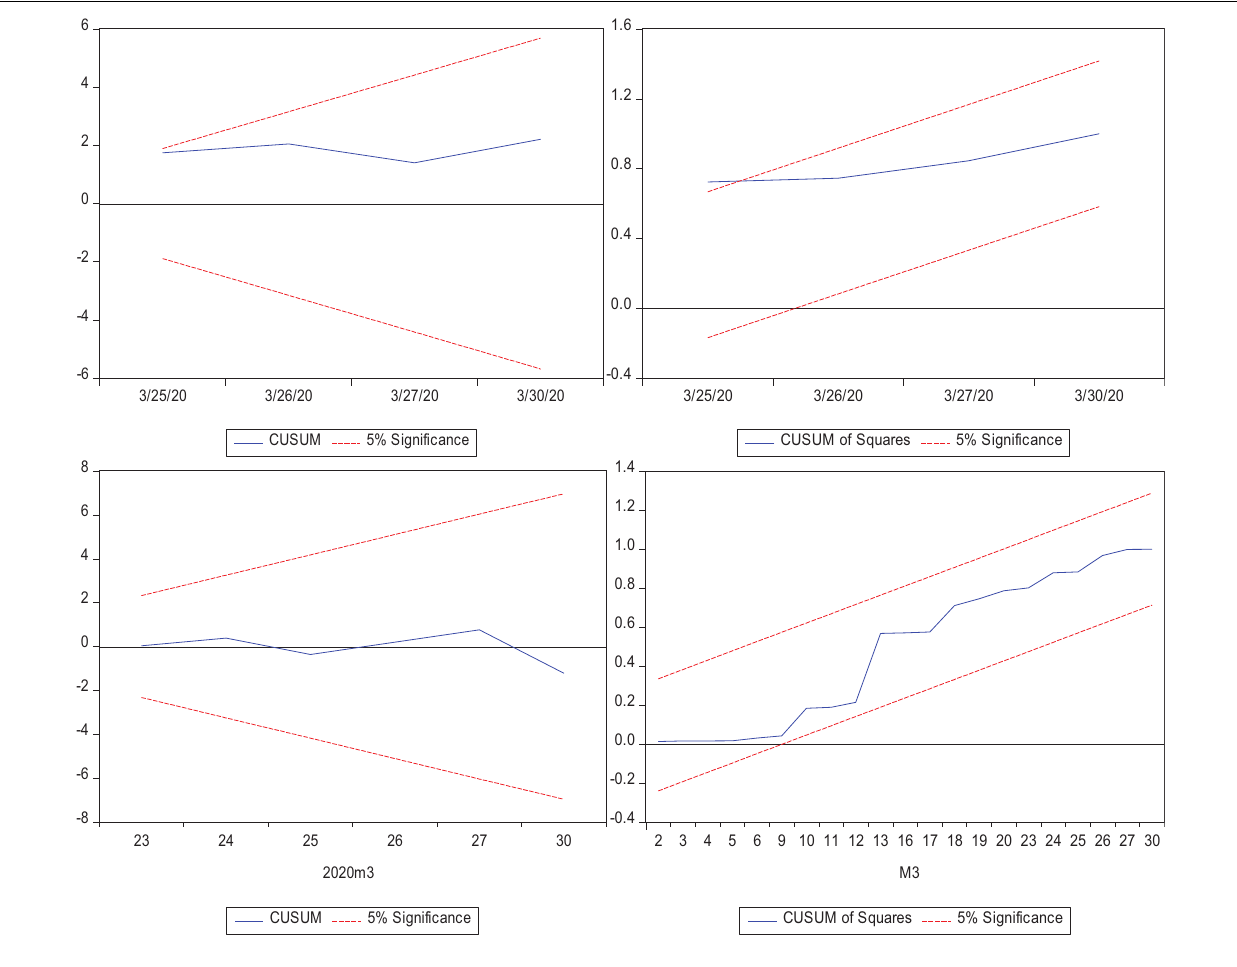
FIGURE 3 | CUSUM and CUSUMSQ